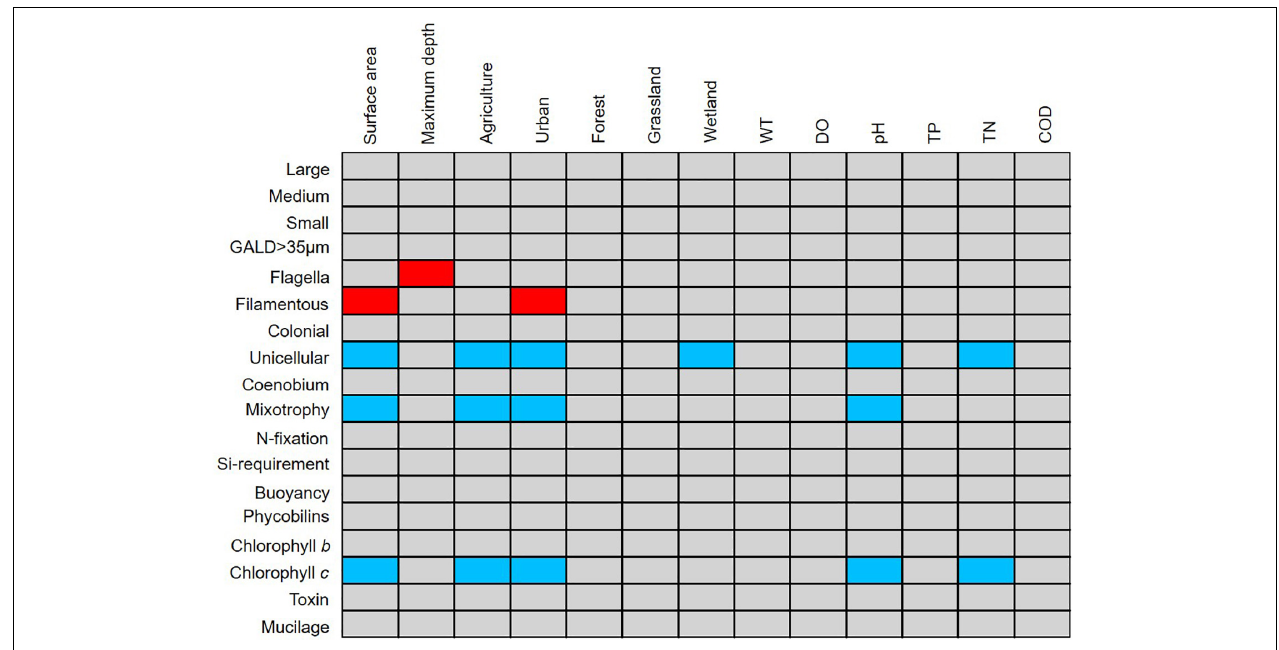
FIGURE 4 | Results of the fourth-corner analysis revealing the correlation between phytoplankton traits and land use and environmental gradient variables in the selected lakes. Red cells indicate significant positive correlations ( p < 0.05) and blue cells indicate significant negative correlations ( p < 0.05).